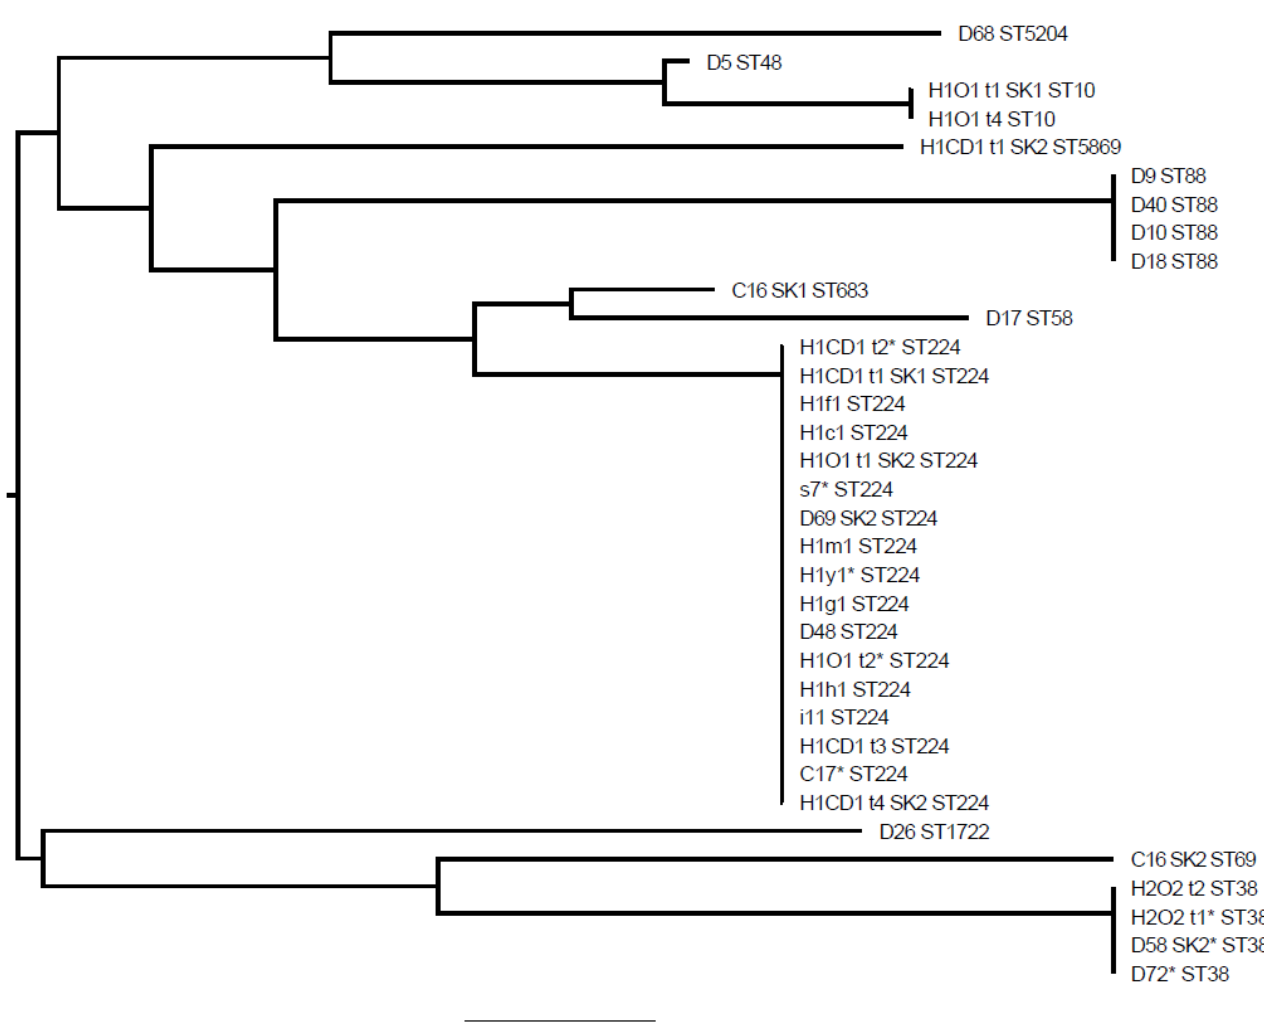
Figure 2. Multi-locus sequence typing-distance based phylogenetic tree for extended-spectrum beta-lactamase-producing